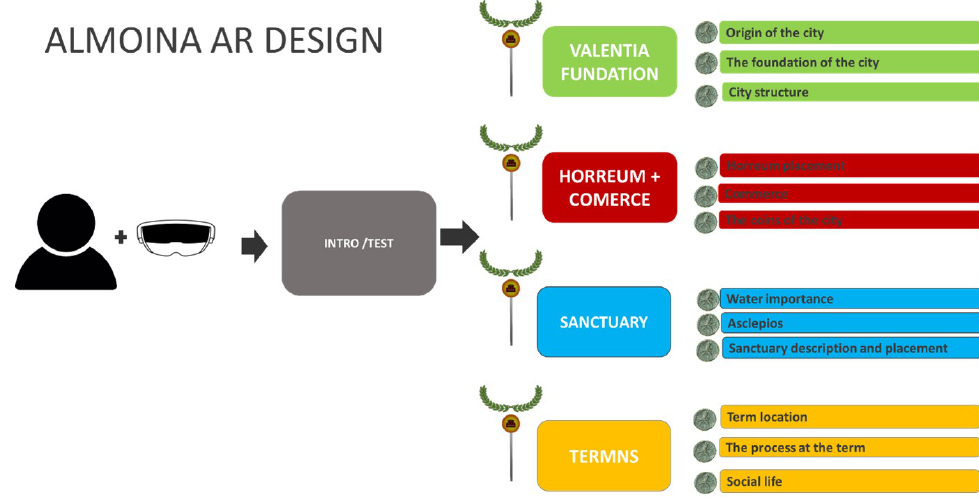
Figure 2. Content